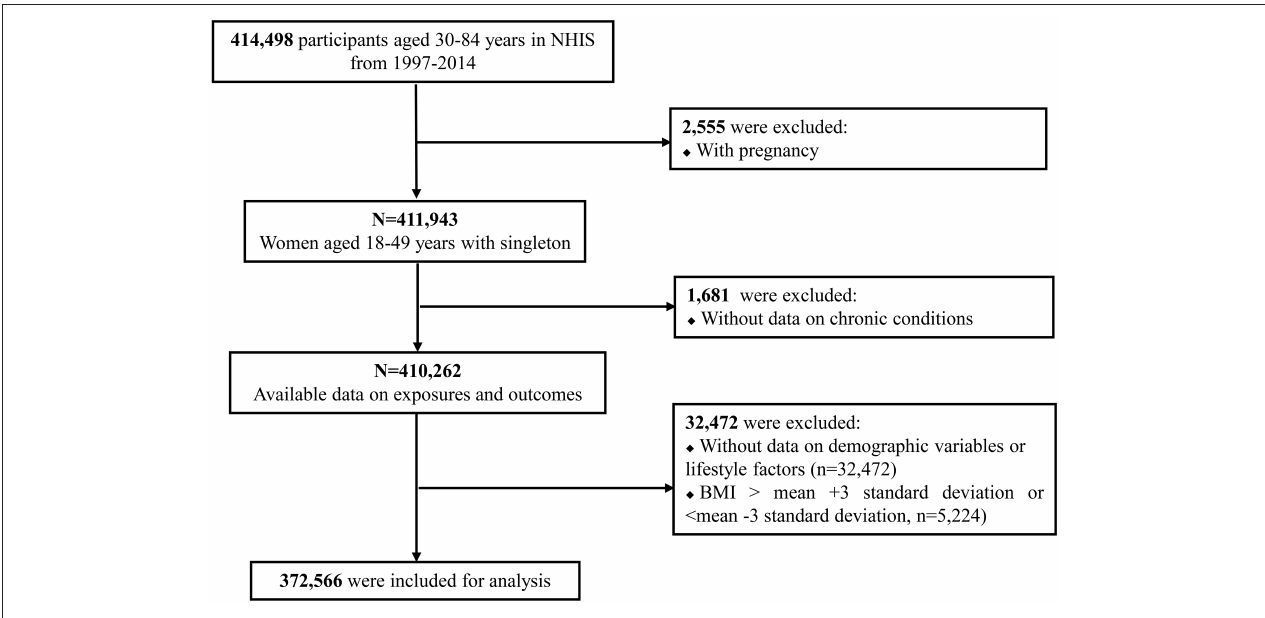
FIGURE 1 | Flowchart of inclusion/exclusion of the study